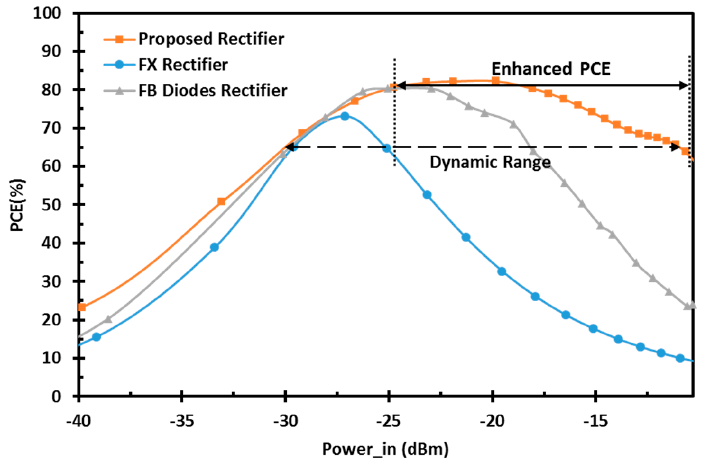
Figure 6. Simulated PCE for conventional FX and FB diodes, and proposed rectifiers vs. the input RF power.